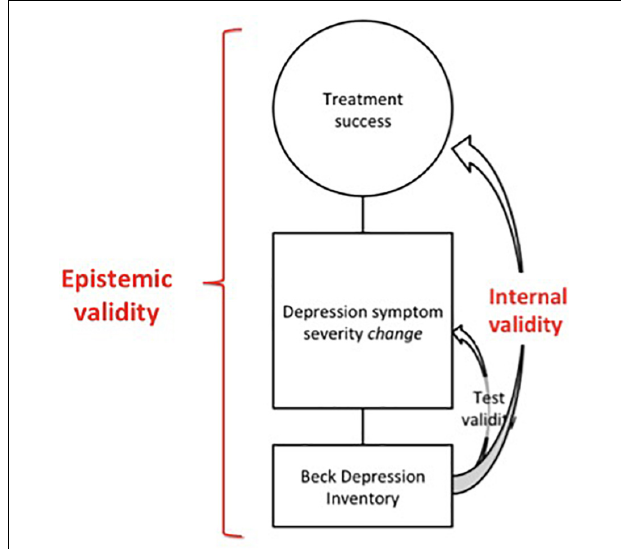
FIGURE 5 | The validity of the research process entails both the internal validity of the design and the epistemic validity of the function of the design